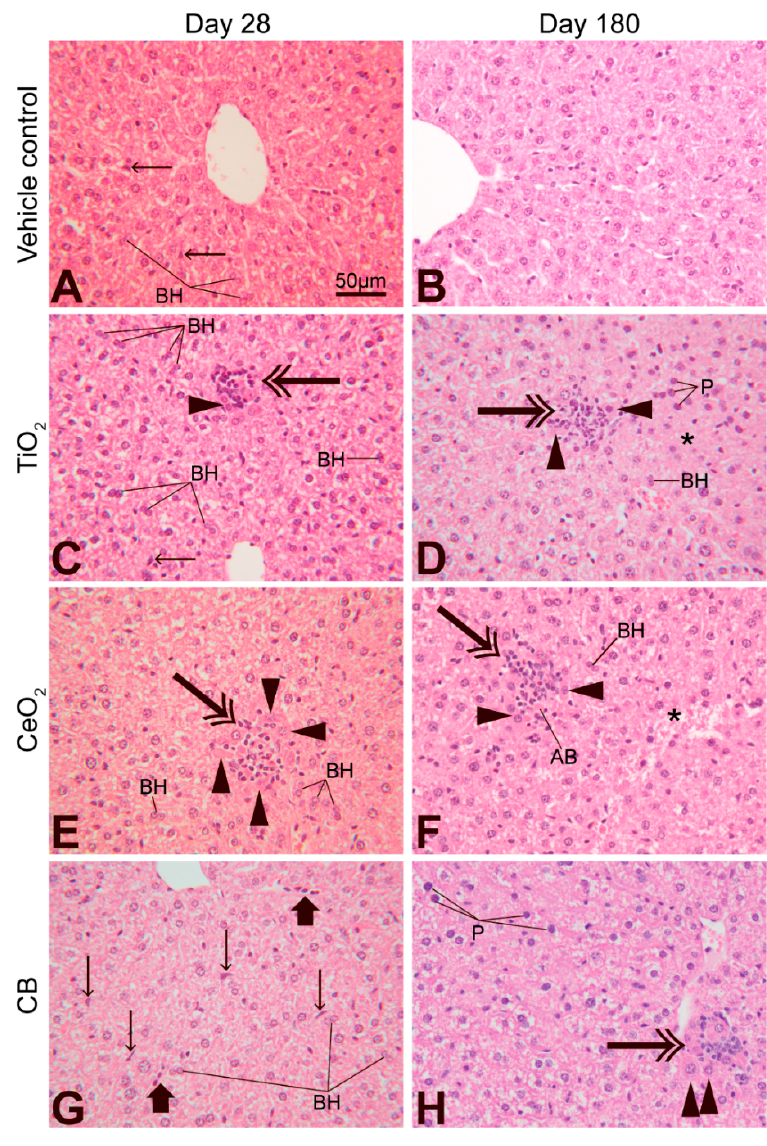
Figure 3. Microscopic changes in the liver of mice 28 ( A , C , E , G ) or 180 days ( B , D , F , H ) after single intratracheal instillation (IT) of a vehicle ( A , B ), TiO 2 ( C , D ), CeO 2 ( E , F ) or carbon black (CB) ( G , H ) nanoparticles. Prominent nuclei of Kupffer cells (tiny arrows); binucleate hepatocytes (BH); focal infiltration of inflammatory cells (double arrows); necrotic hepatocytes with distinct eosinophilic cytoplasm (arrowheads); pyknosis of nuclei of hepatocytes (P); cytoplasmic vacuolation (white spaces in hepatocytes); area of necrosis (asterisk); hyperplasia of Kupffer cells (thick arrows). HE stain, scale bar in A applies to all images.